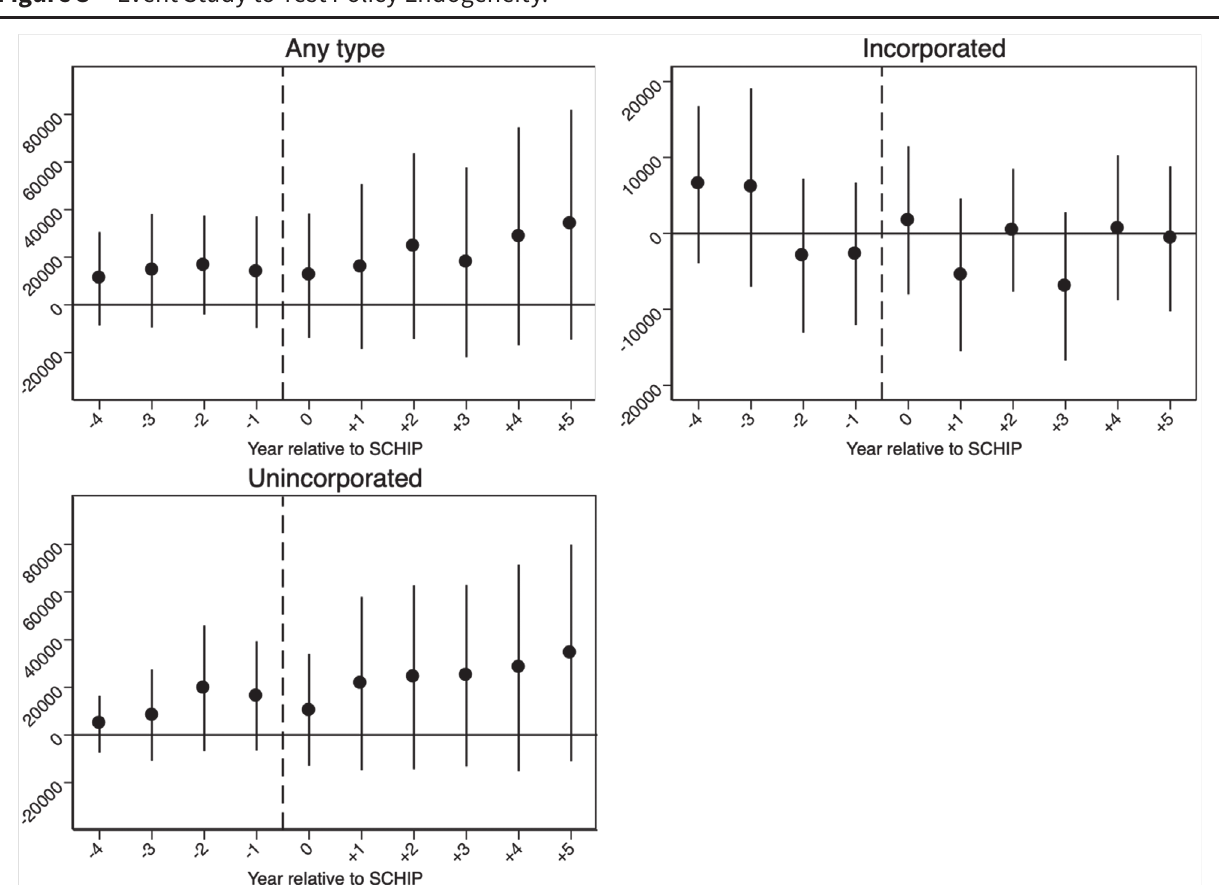
Figure 3 Event Study to Test Policy